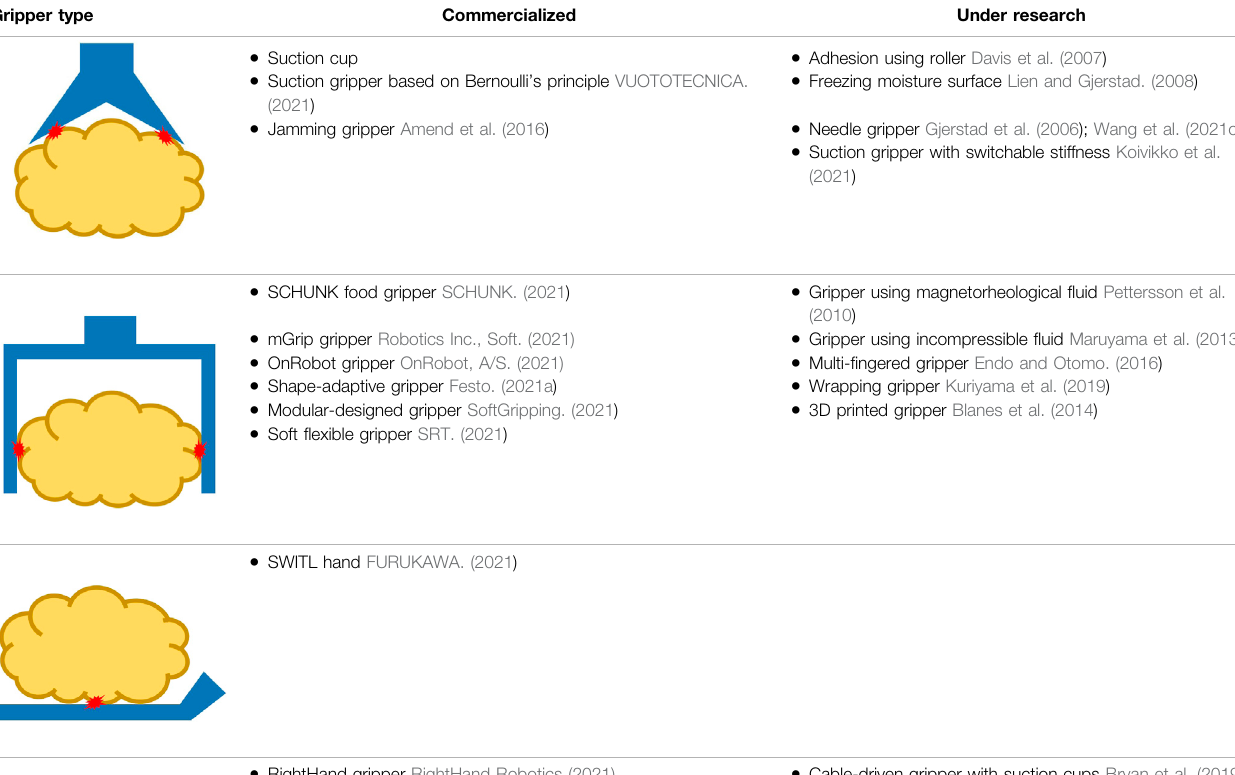
TABLE 1 | Summarization of robotic end-effectors for food